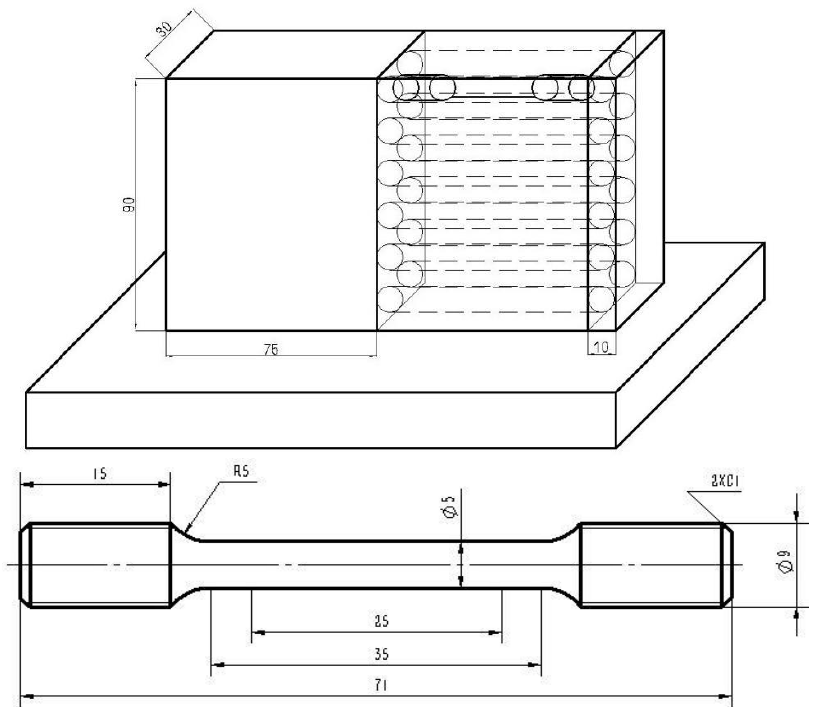
Figure 2. Schema of specimen wire cut electrical discharge machining (WEDM).